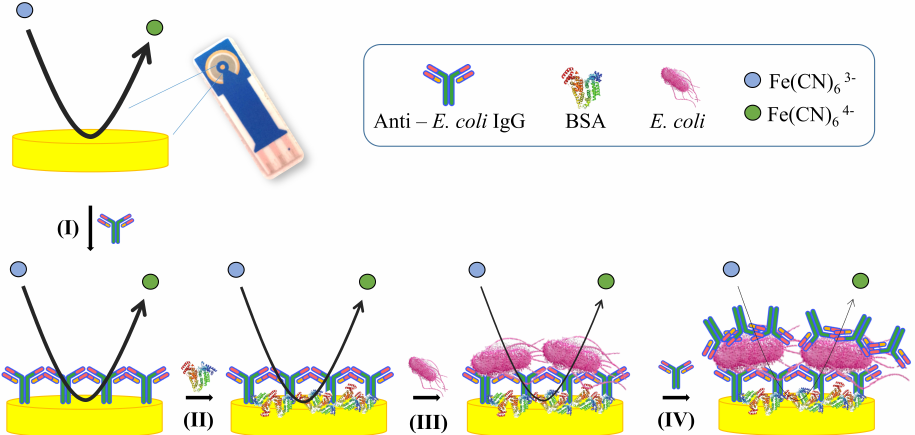
Scheme 1. Schematic diagram (not in scale) of the stepwise functionalization and detection. The black line represents the intensity of the redox reaction, which is inhibited as the surface covering grows.